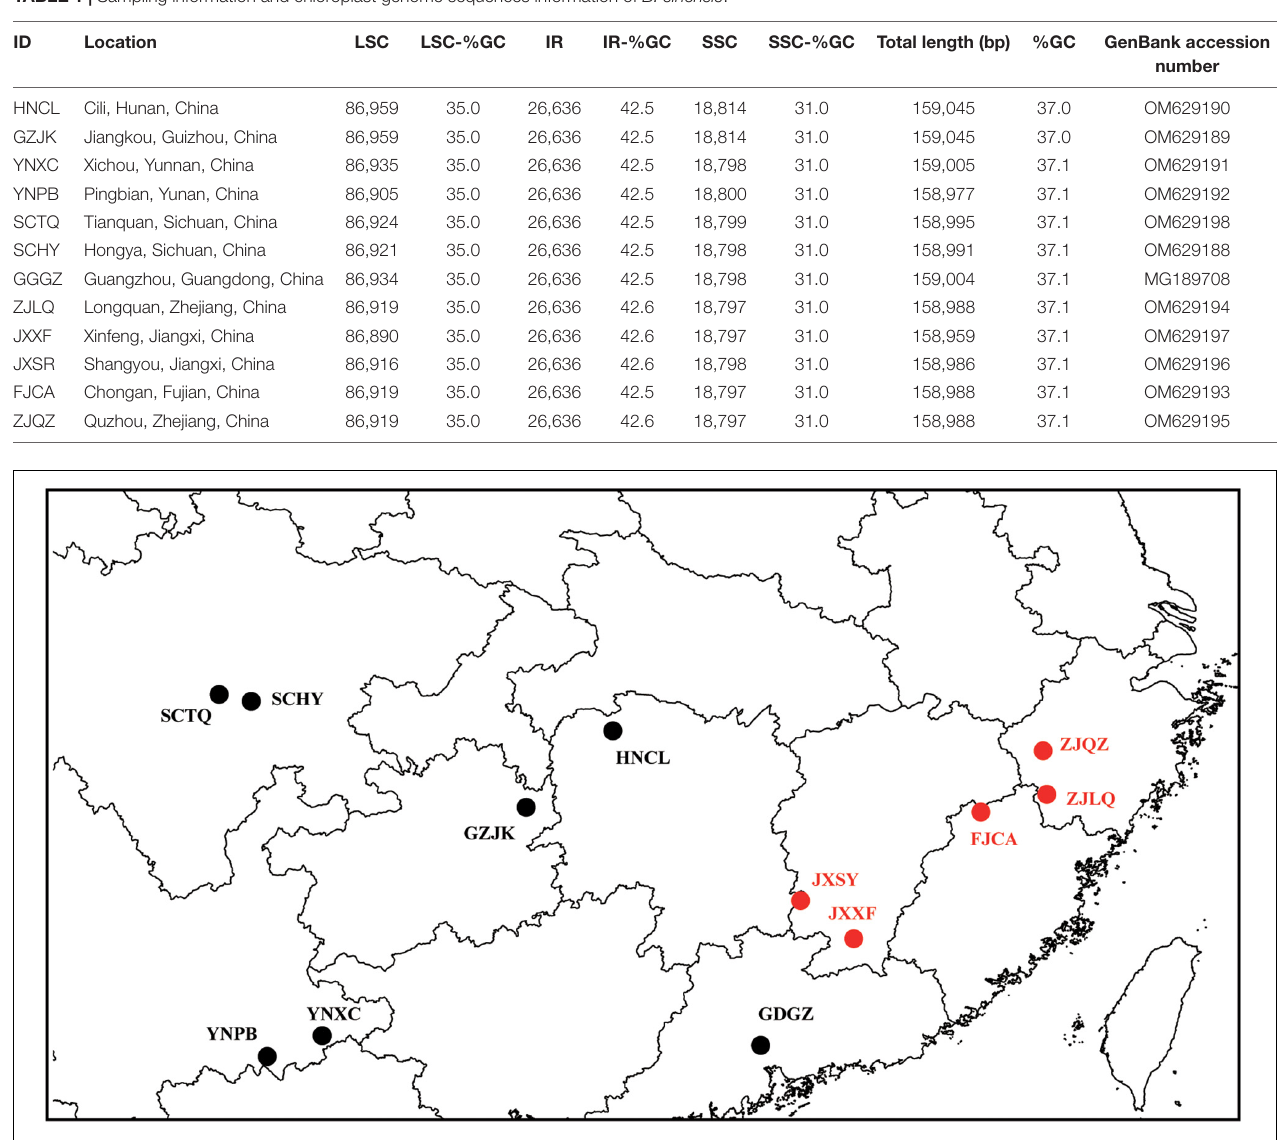
Codes Corporation, Ann Arbor, MI, United States 1 ). The gaps between the contigs were filled using the clean reads that were mapped to the contigs using Geneious 8.1 (Kearse et al., 2012). Whole chloroplast sequences were annotated using Plann (Huang and Cronk, 2015) and the published sequence of B. sinensis (GenBank accession number: MG189708) was used as the reference. Annotation was confirmed in Geneious. Complete chloroplast genomes were depicted using OGDRAW